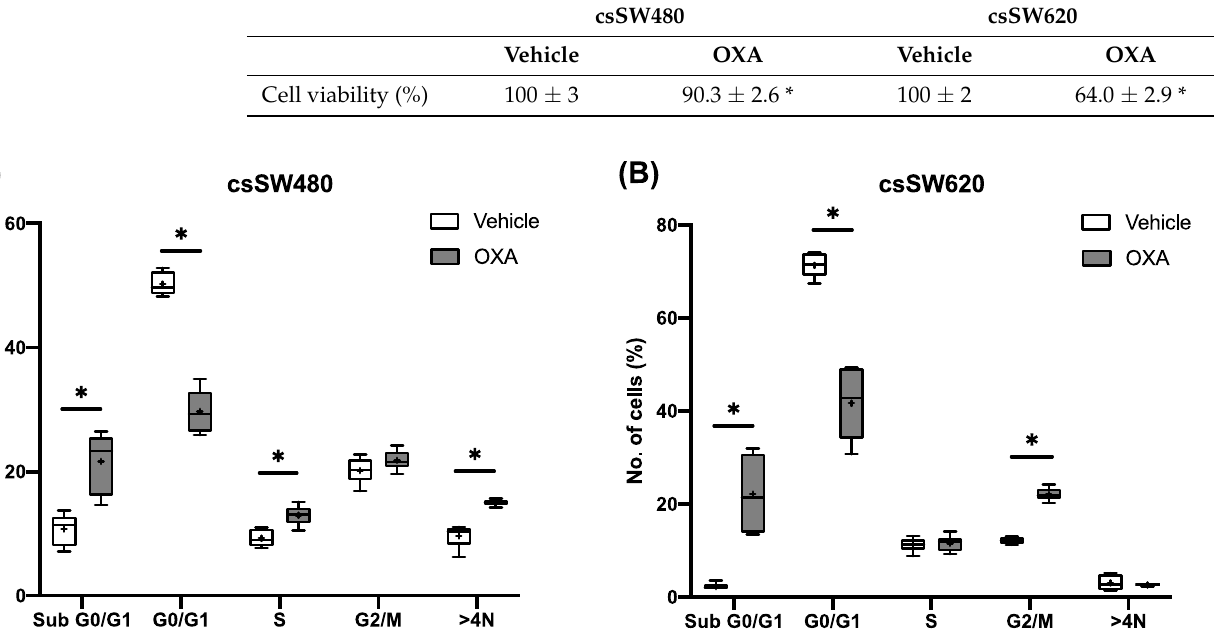
Figure 1. Cell cycle represented by number of cells (%) for SW480 ( A ) and SW620 ( B ) tumourspheres after 96 h of vehicle (0.1% DMSO) or oxaliplatin 5 µ M treatment. Each box represents the interquartile range (25th to 75th percentiles), the central horizontal line is the median value, and the whiskers represent the minimum and the maximum values ( n ≥ 4). Student’s test or Mann–Whitney test were performed to determine the significance between the experimental groups. Statistical significance was set at * p < 0.05.